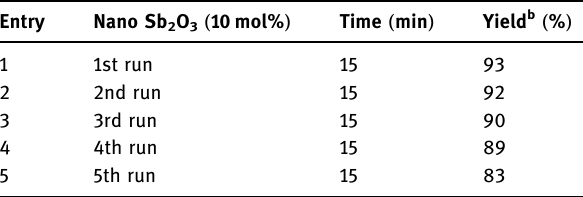
Table 3: Reusability of the catalyst, nano Sb 2 O 3 ( 10 mol% ) , for